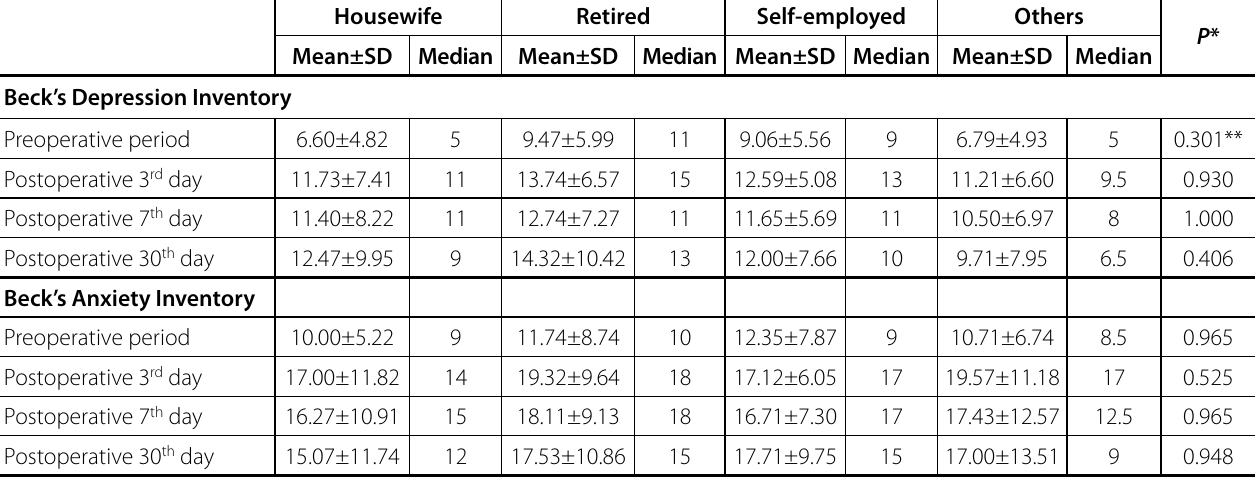
Table 7 . Statistical correlation between profession and Beck’s depression and Beck’s anxiety test values(no significant value; P